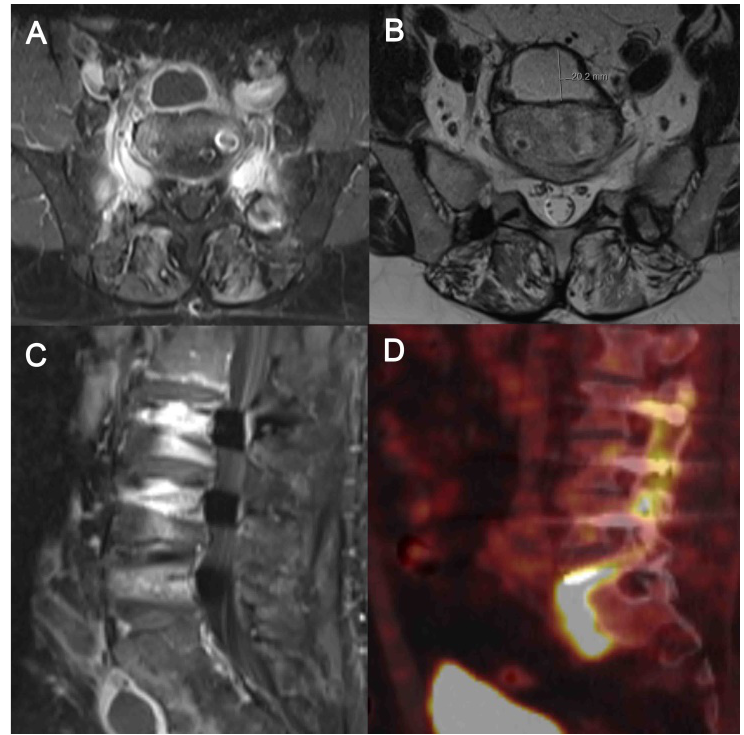
Figure 1. MRI and PET-CT indicated a small abscess anterior (20.2 mm in diameter, B) to segment L5/S1. A, transversal T1 sequence of MRI with contrast medium. B, transversal T2 sequence of MRI with contrast medium. C, sagittal T1 sequence of MRI with contrast medium. D, PET-Scan of the lumbar